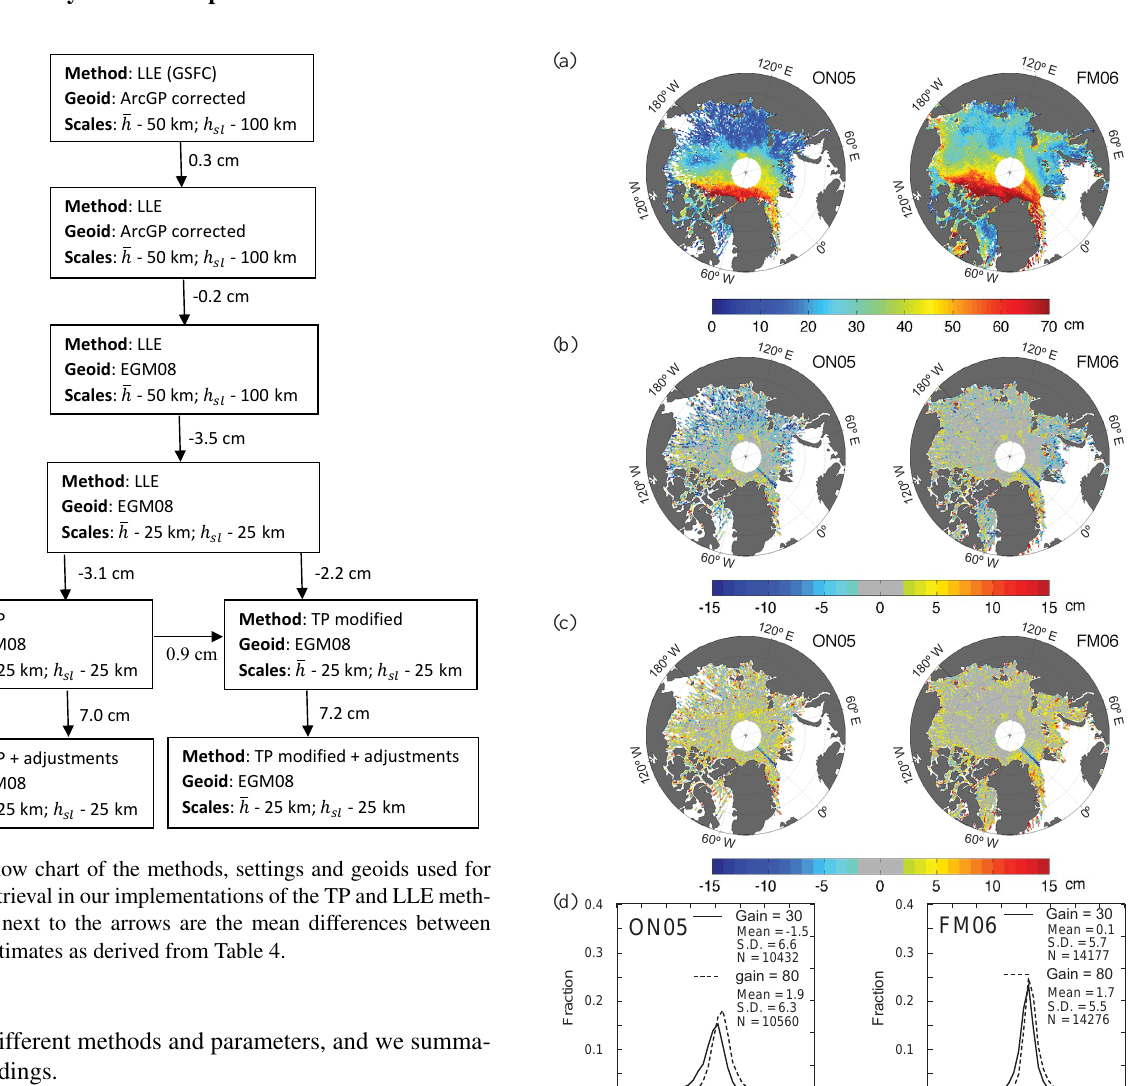
ferences for the other periods are recapped in Table 2 (first line). The mean differences are small, i.e. around ± 2 cm, in- dicating good agreement between the estimates. The remain- ing discrepancies can be attributed to different data filtering and possibly to the differences existing between data releases (e.g. improvements in saturation